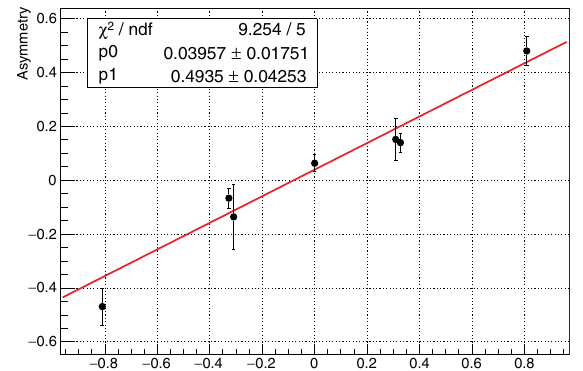
Figure 4. The angular dependence of A LH . The solid line shows the linear fit using the function of Eq.